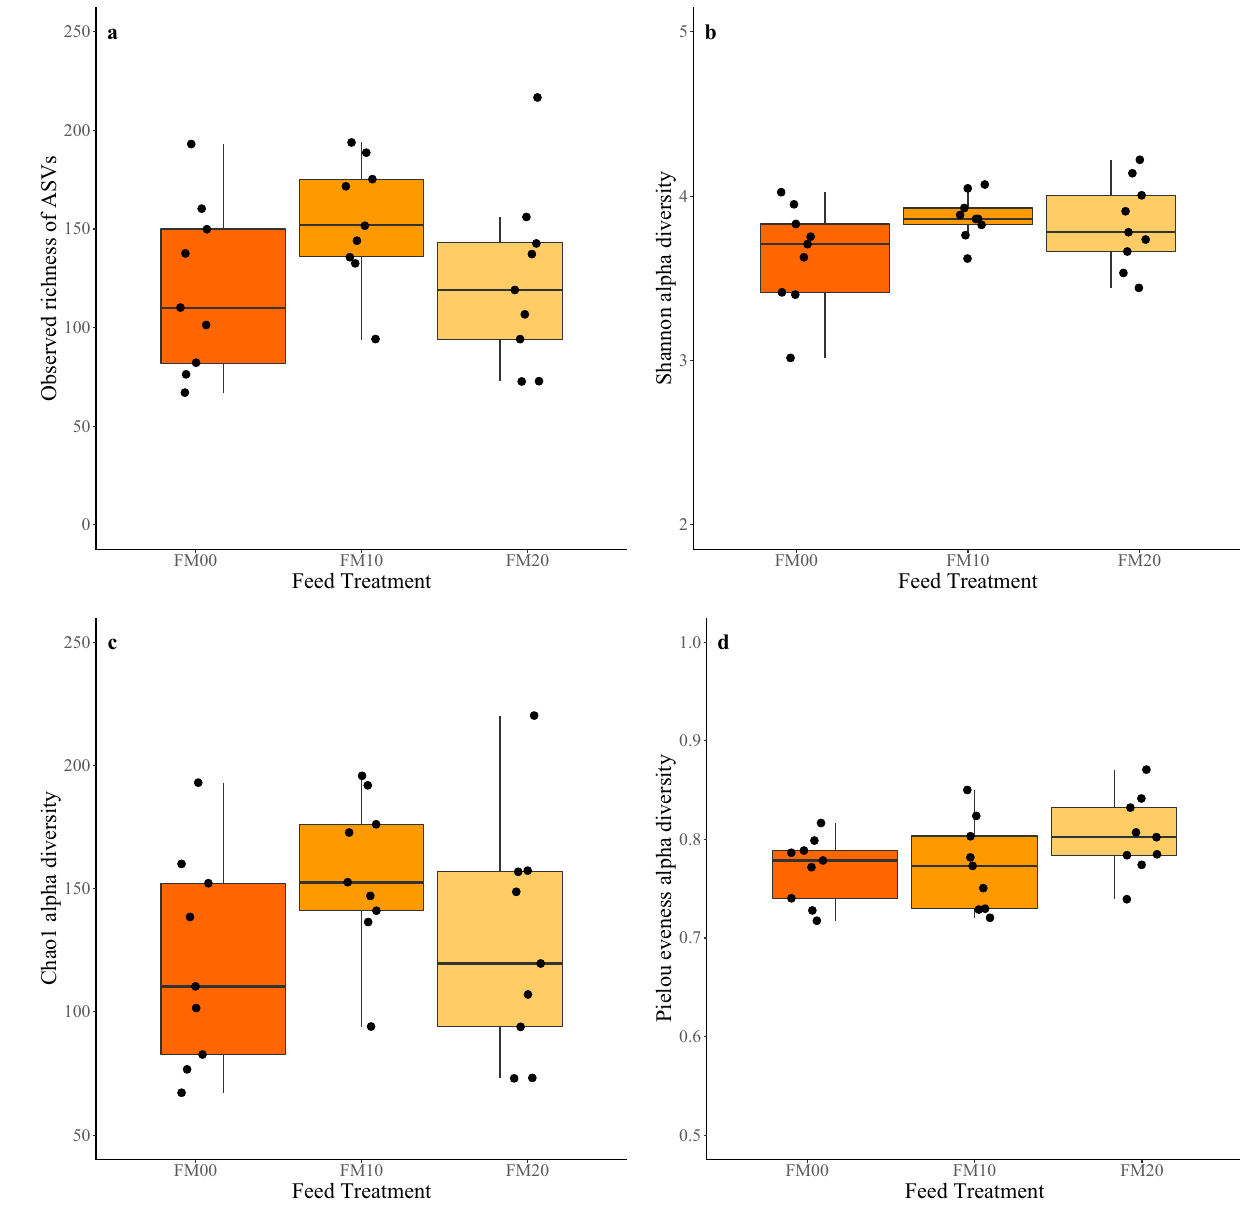
Figure 2. Box plots of alpha diversity measures for the FM feed treatments ( a) the observed richness of ASVs, ( b) Shannon diversity, ( c) Chao1 diversity, ( d) Pielou’s